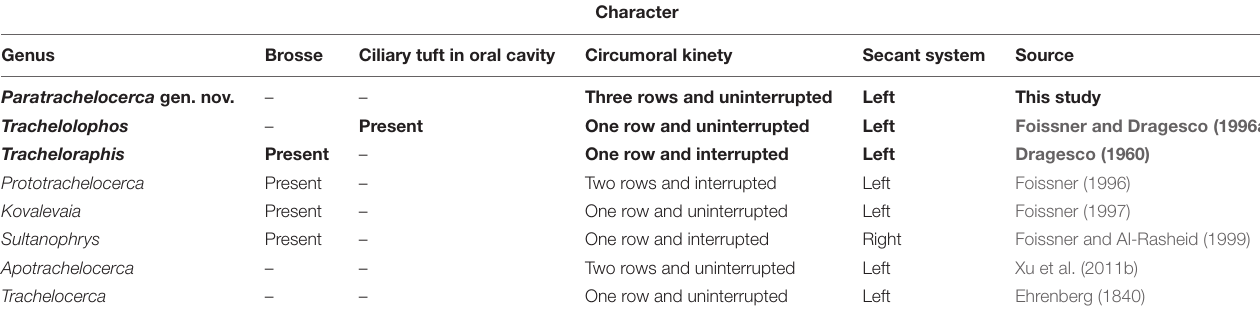
TABLE 2 | Distinction among genera in trachelocercid karyorelictids.